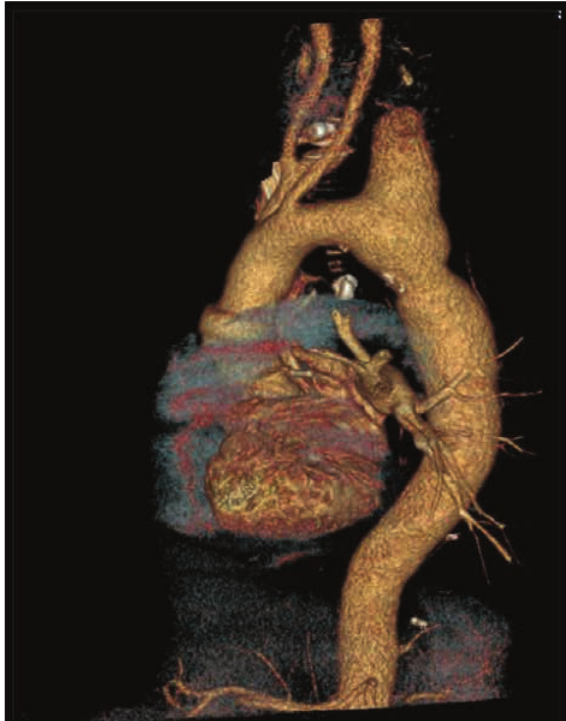
Figure 1: Left subclavian artery aneurysm. Mild aortic coarctation is visible below its origin.